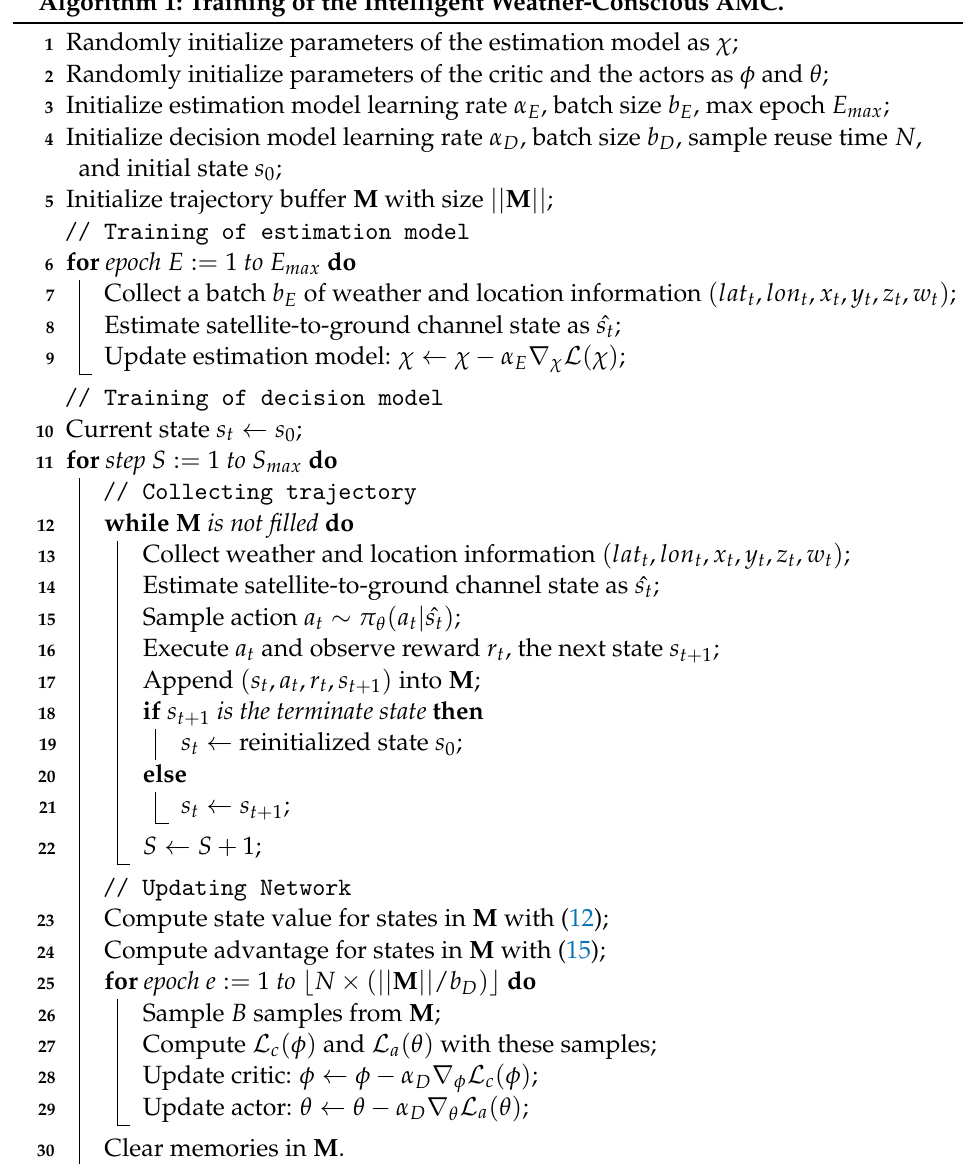
Algorithm 1: Training of the Intelligent Weather-Conscious